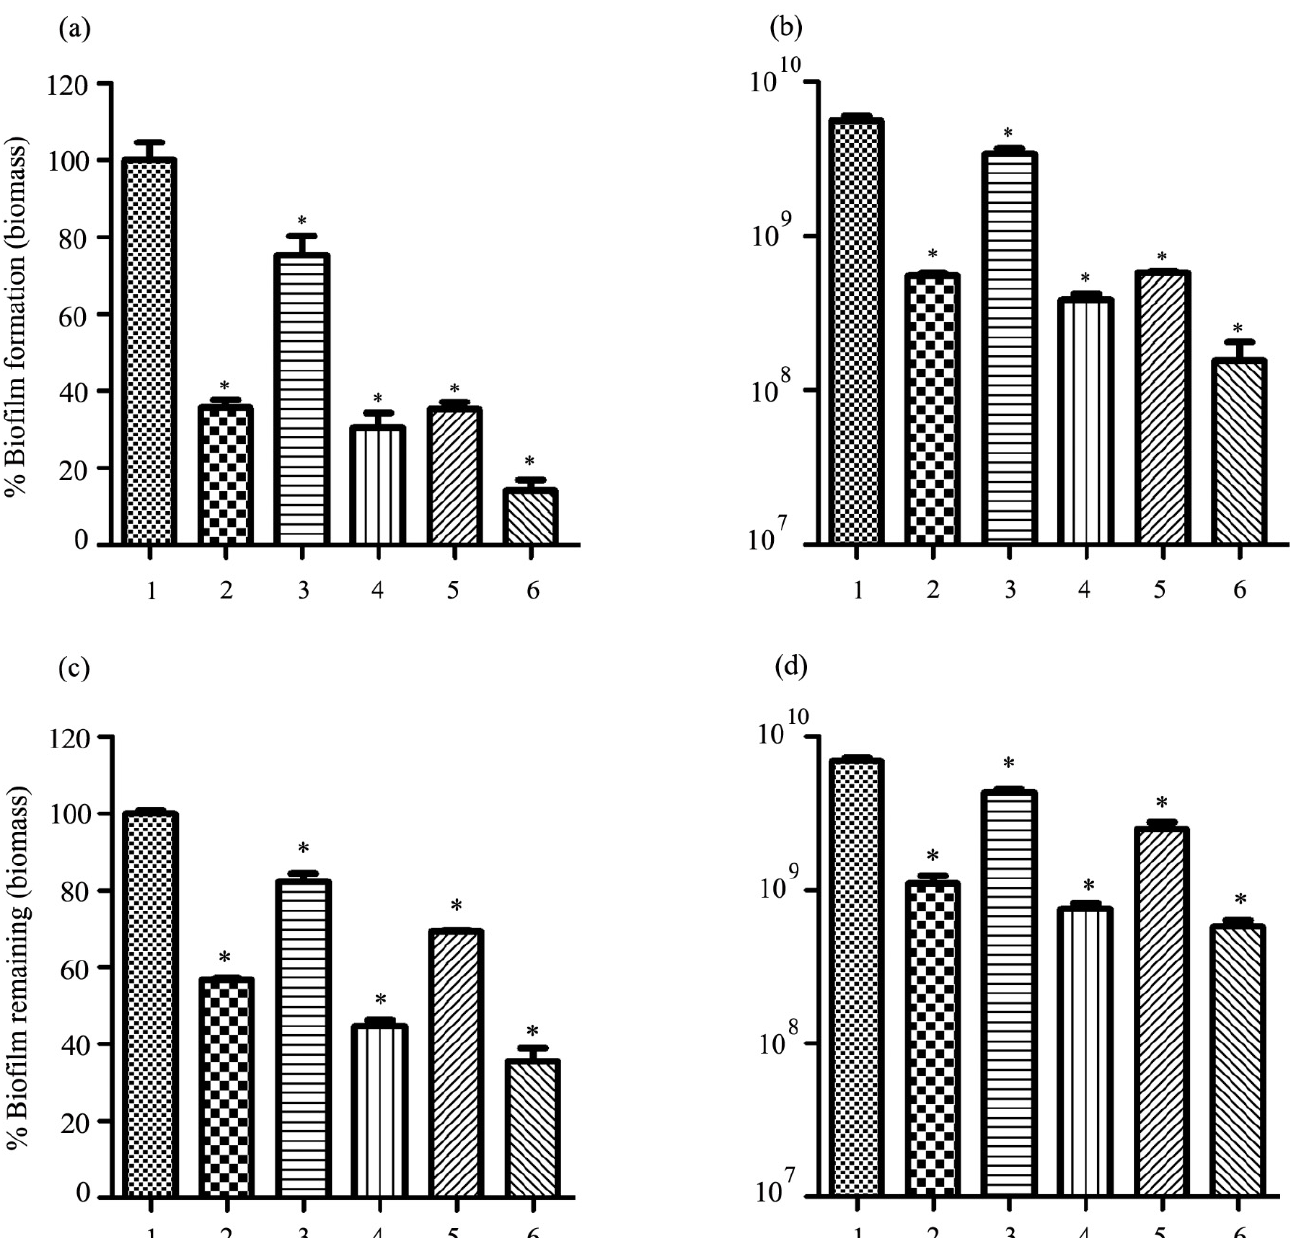
Figure 10. Antibiofilm activity of the combination of phage vWUPSU and sacha inchi oil. The efficacy of the combined phage vWUPSU and sacha inchi oil to reduce biofilm formation was evaluated. ( a ) Biofilm’s biomass and ( b ) bacterial cell viability were assessed. The effect of the combination of phage vWUPSU and sacha inchi oil to remove preformed biofilm was studied. ( c ) Biofilm’s biomass and ( d ) bacterial cell viability were quantitated. Experiments were undertaken independently in triplicate with duplicate assay. The data show mean ± SD (*, p value < 0.05). 1 = MDR A. baumannii ; 2 = MDR A. baumannii infected with phage vWUPSU; 3 = MDR A. baumannii treated with sacha inchi oil at 0.5 × MIC; 4 = MDR A. baumannii treated with the combined phage vWUPSU and sacha inchi oil at 0.5 × MIC; 5 = MDR A. baumannii treated with sacha inchi oil at 1 × MIC; 6 = MDR A. baumannii treated with the combined phage vWUPSU and sacha inchi oil at 1 ×